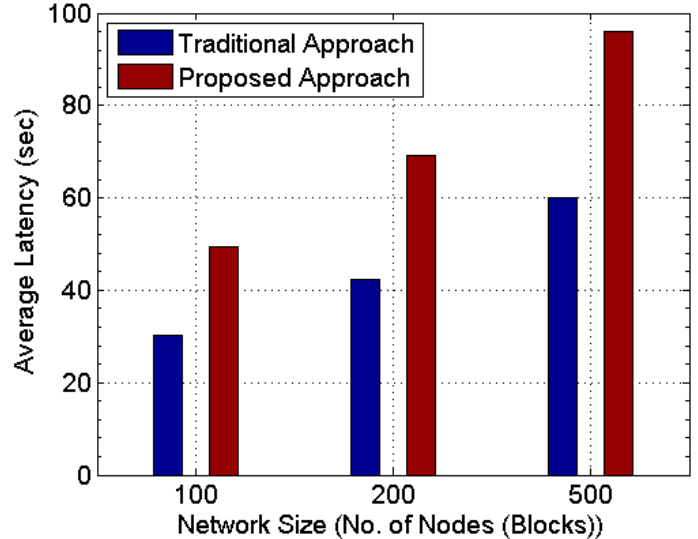
Figure 5. Comparison of average latency for the traditional approach and proposed approach.